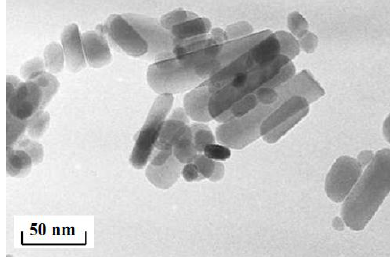
Fig. 1. TEM image of ε -In 0.24 Fe 1.76 O 3 nanoparticles.